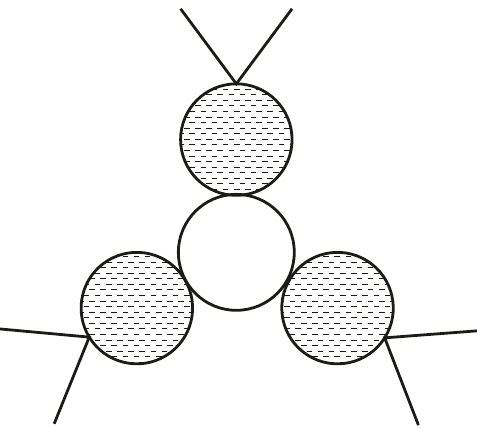
Figure 3 . Contribution to an amplitude including the three-graviton vertex. The shaded circle is de(cid:12)ned in (cid:12)gure